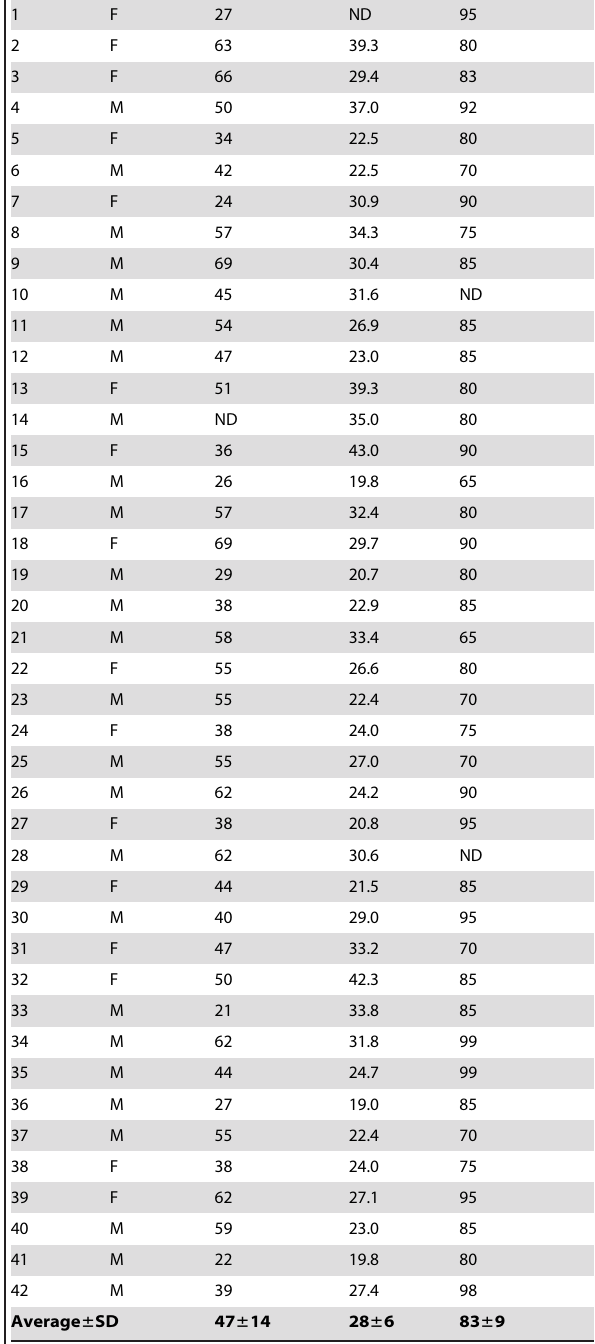
Table 1. Donors of islets used in the